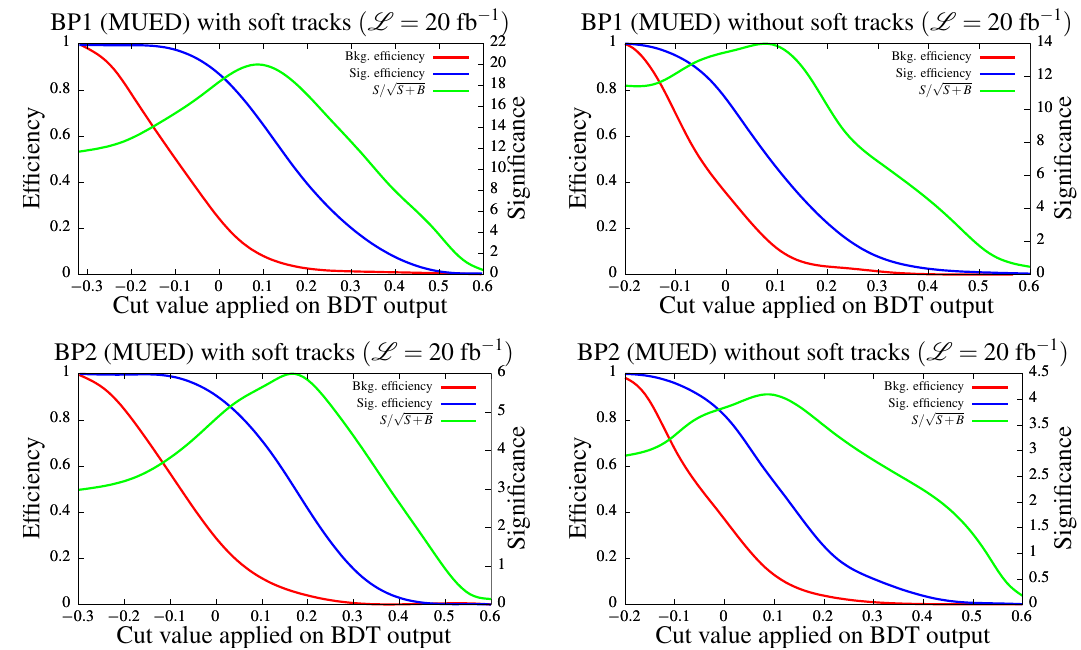
Figure 6 . We show the signal and background e(cid:14)ciencies with respect to the BDT output for MUED. The y -axis on the right hand side shows the signal signi(cid:12)cance pertaining to 20 fb (cid:0) 1 of integrated luminosity as a function of the cut value on the BDT output.